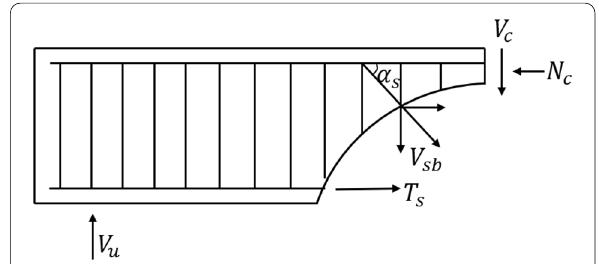
Fig. 10 Bearing capacity composition of inclined section.